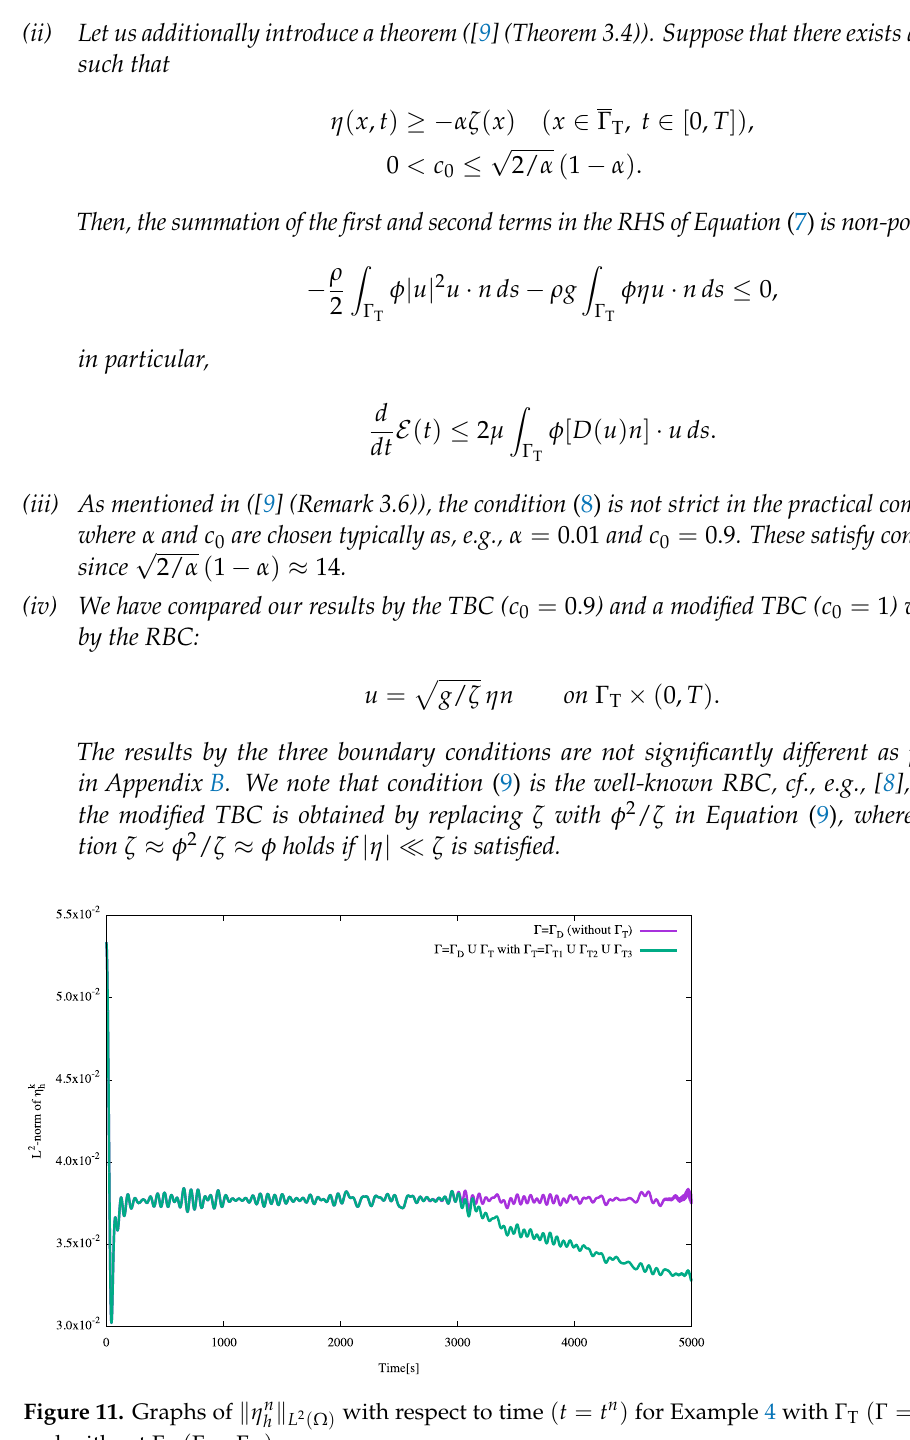
Figure 11. Graphs of (cid:107) η n and without Γ T ( Γ = Γ D )